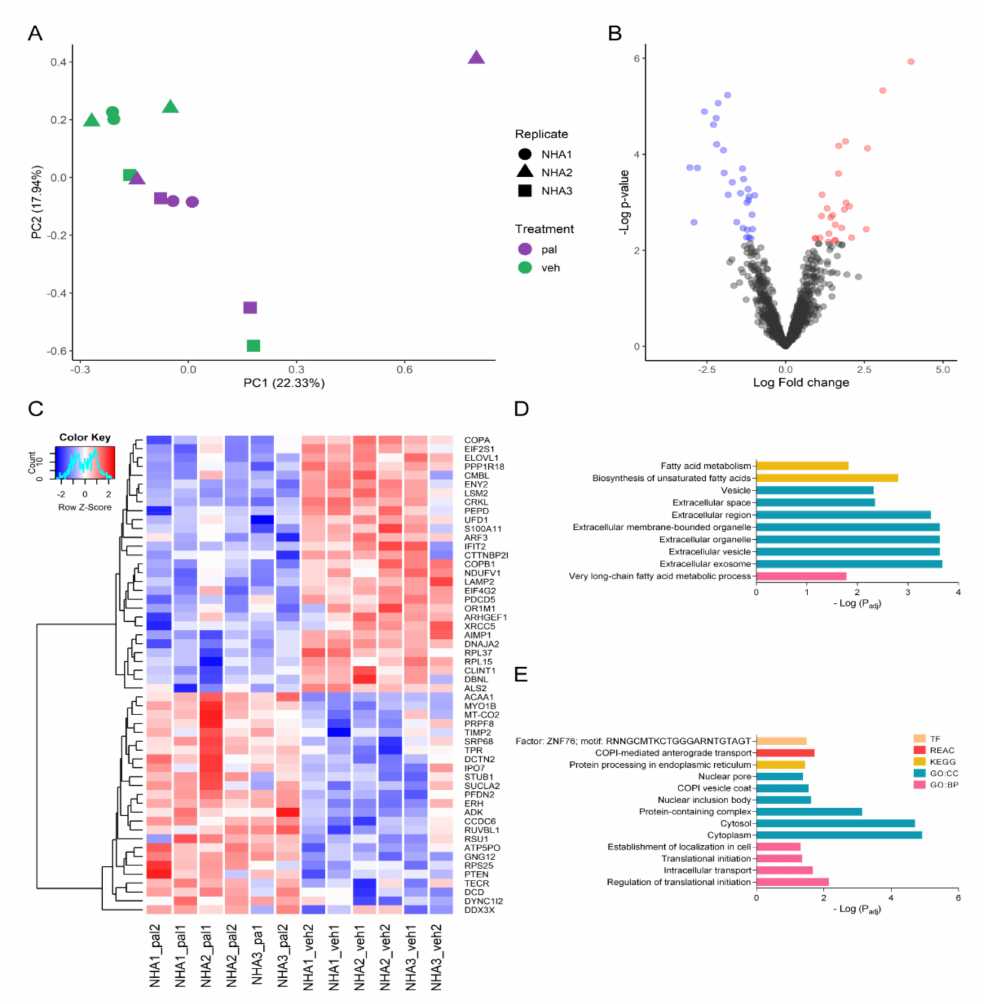
Figure 2. Differential expression of pal vs. veh. ( A ) PCA to evaluate the relationships between biological replicates and pal vs. veh treatments. ( B ) Volcano plot showing differentially expressed proteins with adjusted p -value < 0.01 and |Fold change| ≥ 1.5. ( C ) Heatmap of proteins differentially expressed proteins in pal vs. veh. Color scale: variation of normalized protein abundance (Z-Score). ( D ) Enrichment analysis of up-regulated proteins in pal vs. veh ( p < 0.05). ( E ) Enrichment analysis of down-regulated proteins in pal vs. veh ( p < 0.05). TF: TRANSFAC database; REAC: Reactome database; KEGG: Kyoto Encyclopedia of Genes and Genomes; GO:CC: Gene Ontology cellular component; GO: BP: Gene Ontology biological